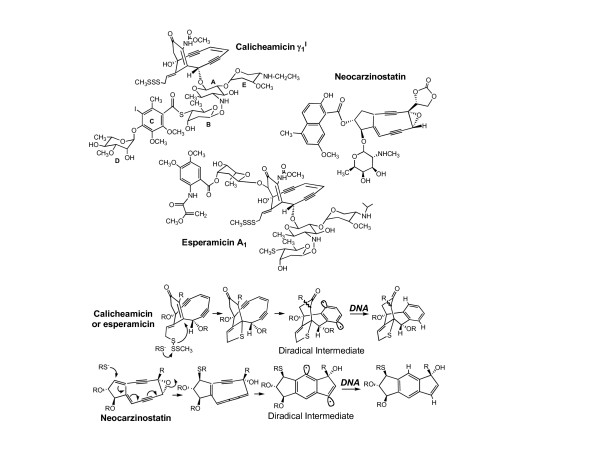
Chemical structures and relative ratios of double-strand to single-strand lesions generated. Three enediynes were used for treatment in S. cerevisiae including calicheamicin γ1I, esperamicin A1 and neocarzinostatin. Each of these results in varying ratios of double-strand (DS) to single-strand (SS) lesions in DNA as outlined in Table 1.